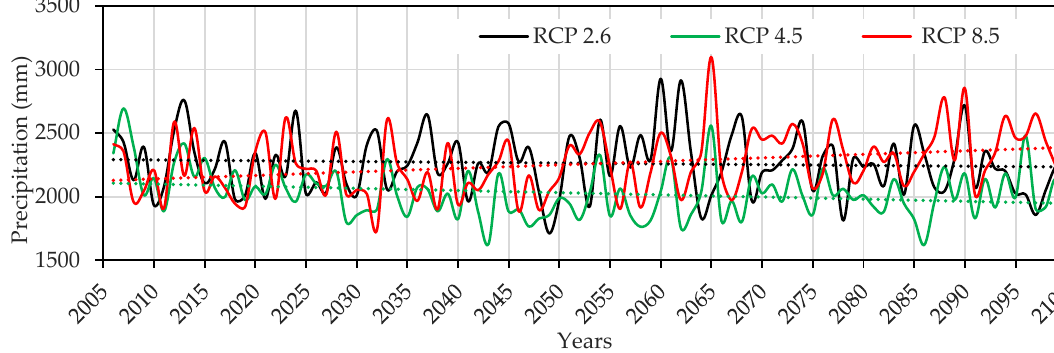
Figure 8. Projected average annual precipitation for the basin under three RCPs.